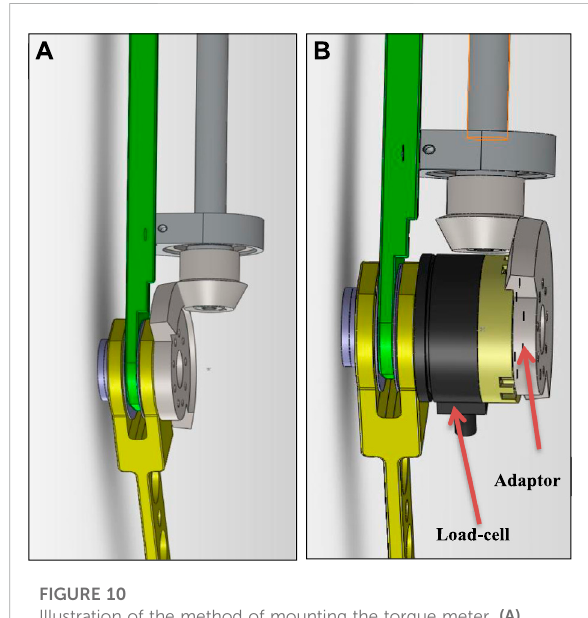
FIGURE 10 Illustration of the method of mounting the torque meter. (A) Normal use without the torque meter. (B) Con fi guration with the torque meter